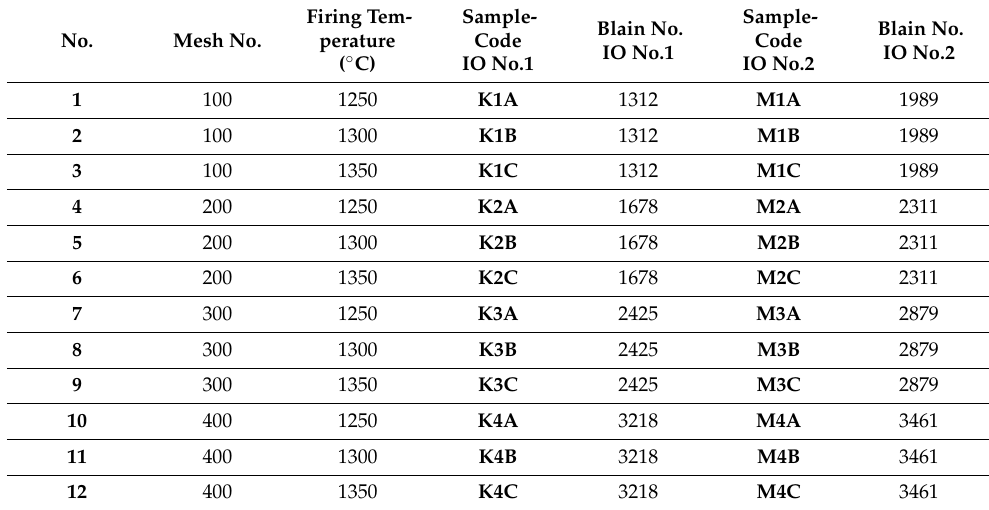
Table 3. Prepared Samples by using different blain fineness and firing